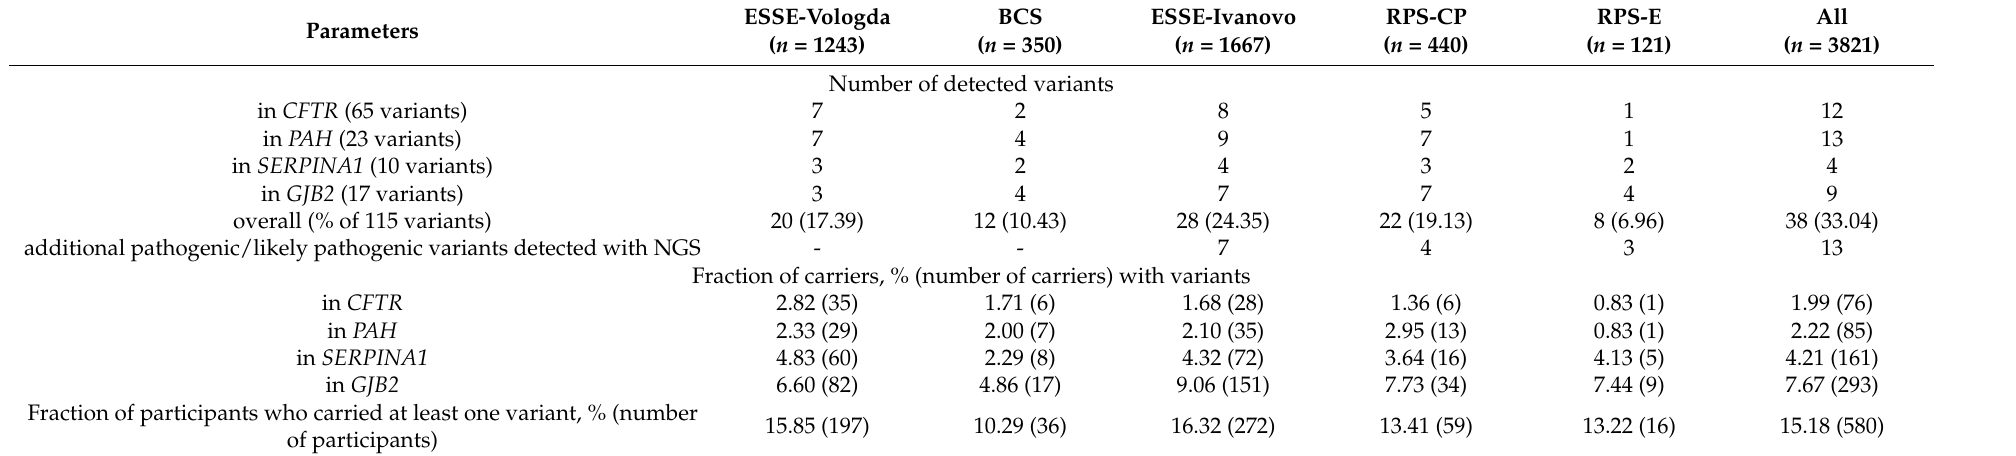
Table 2. The distribution of the detected variants from the custom panel in the studied groups of